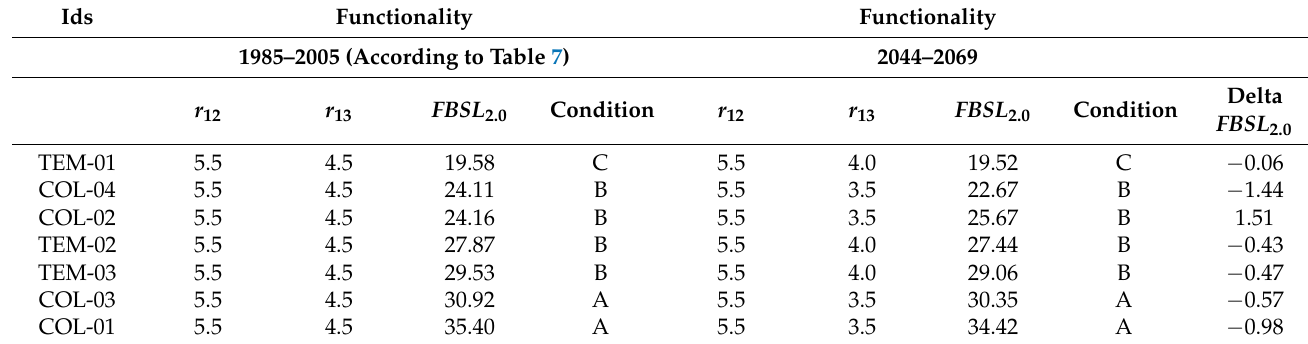
Table 8. Functional performance of the seven timber structures in the cities of Temuco and Collipulli before and after climatic variations (RCP8.5) for